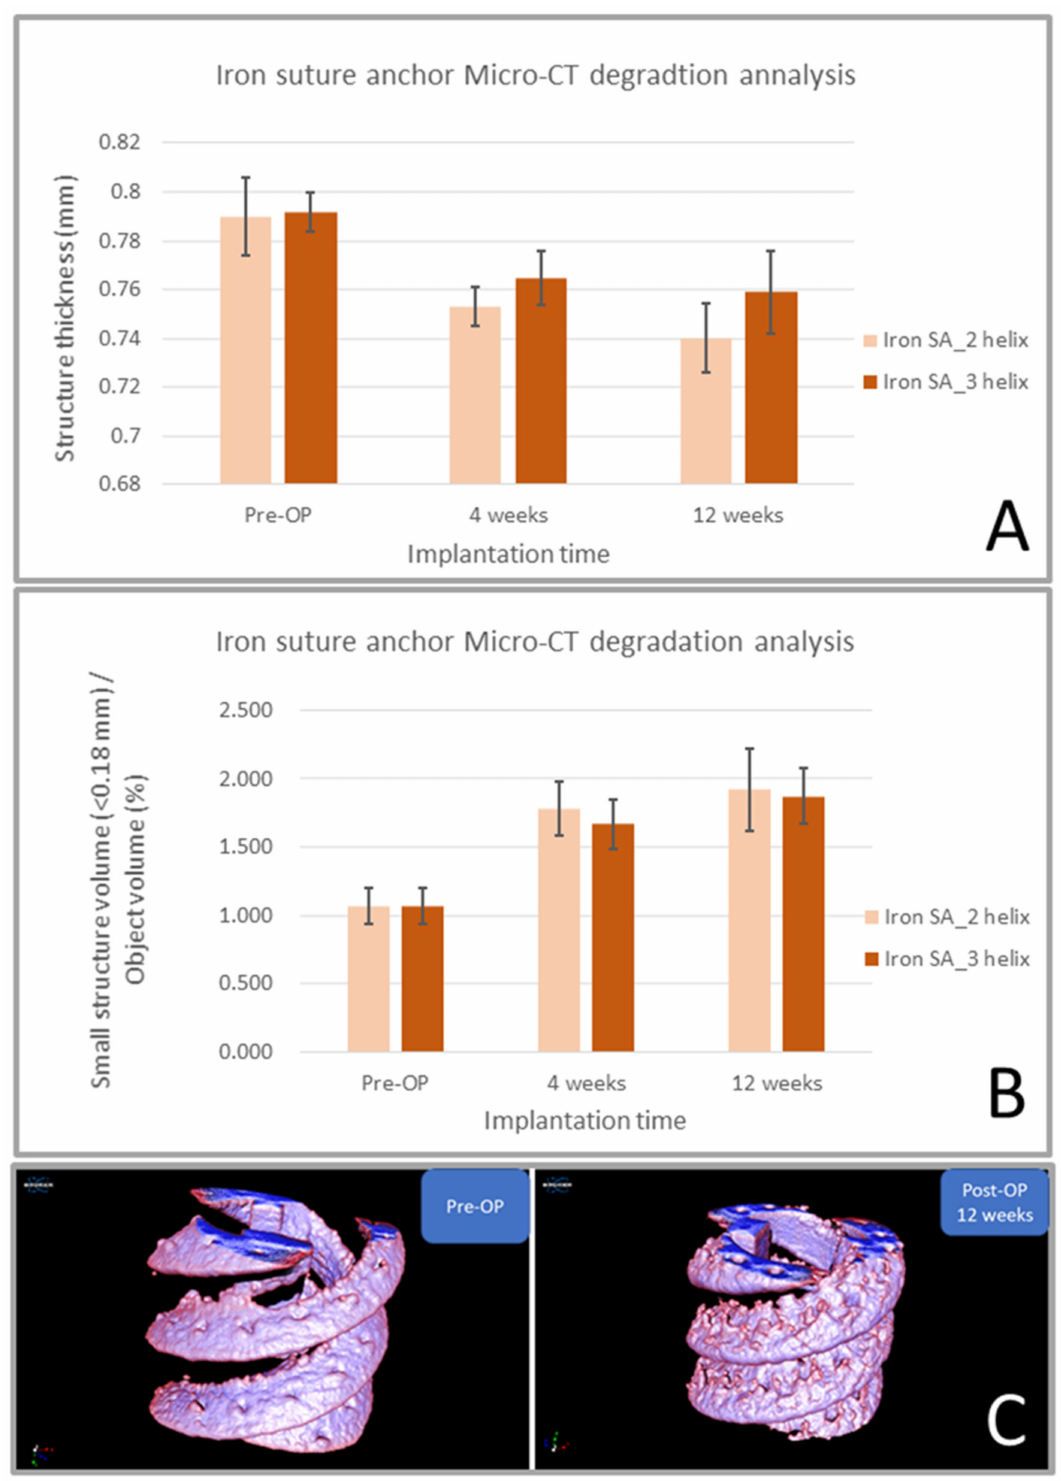
Figure 5. Micro-computed tomography (CT) degradation analysis of the iron suture groups. ST decreased ( A ) and SSV/OV percentage increased ( B ) sequentially from the preoperative period until 12 weeks postoperatively. Reconstructed micro-CT images observed preoperatively and at 12 weeks postoperatively ( C ). ST: structure thickness (mm), SSV: small implant fragments < 0.18 mm in diameter (small-structure volume), OV: object volume, and SSV/OV (%) denoted the small fragment percentage of the implant in the region of interest. The error bar represents the standard